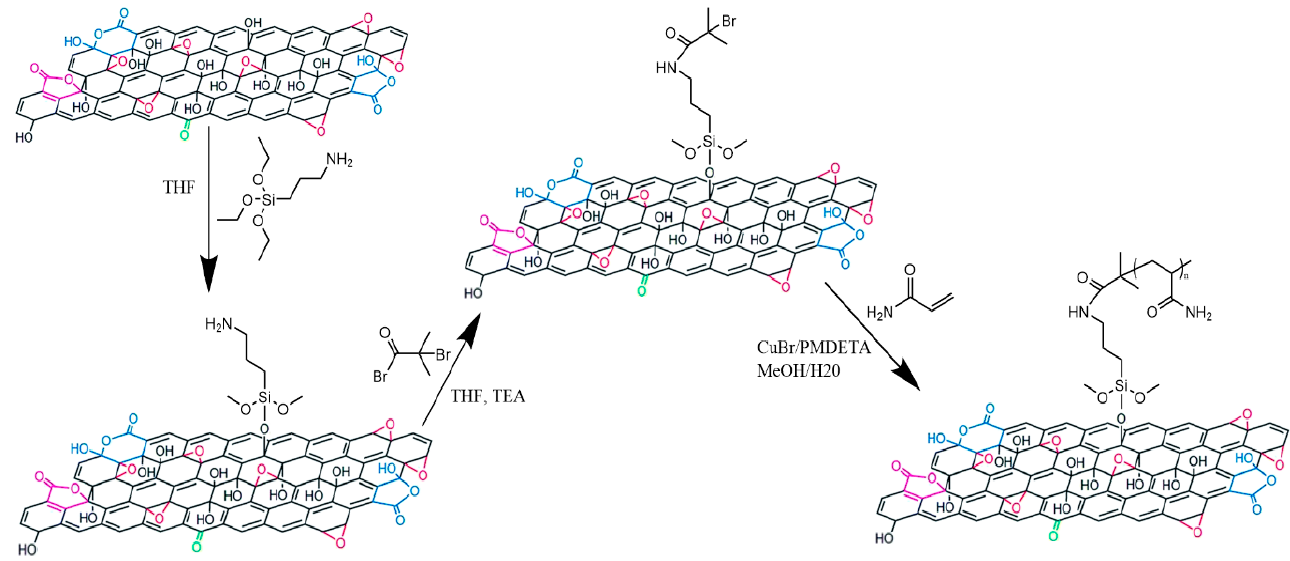
Figure 1. Synthetic route leading to formation of PAAM brushes on graphene oxide (GO): APTES grafting (first step), BIBB treatment (second step) and surface-initiated atom transfer radical polymerization (SI-ATRP) of acrylamide (third step).